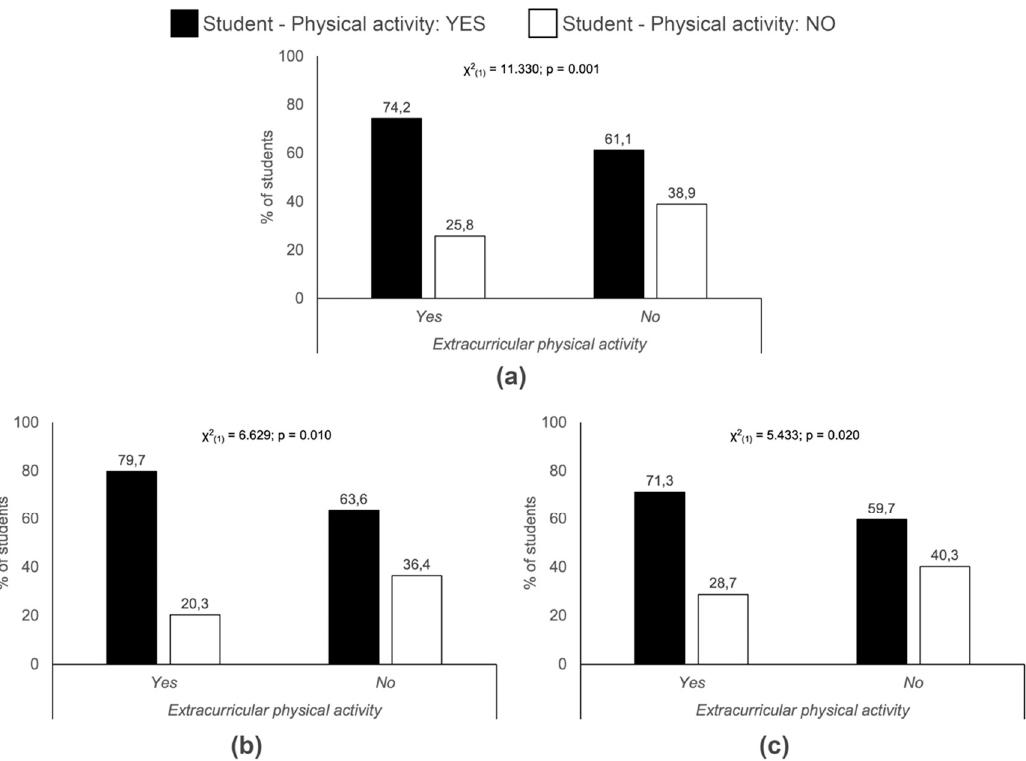
Figure 4. Relation between physical activity and participation in extra-curricular sports activities organized by the educational centre. ( a ) Total sample; ( b ) Men; ( c ) Women.